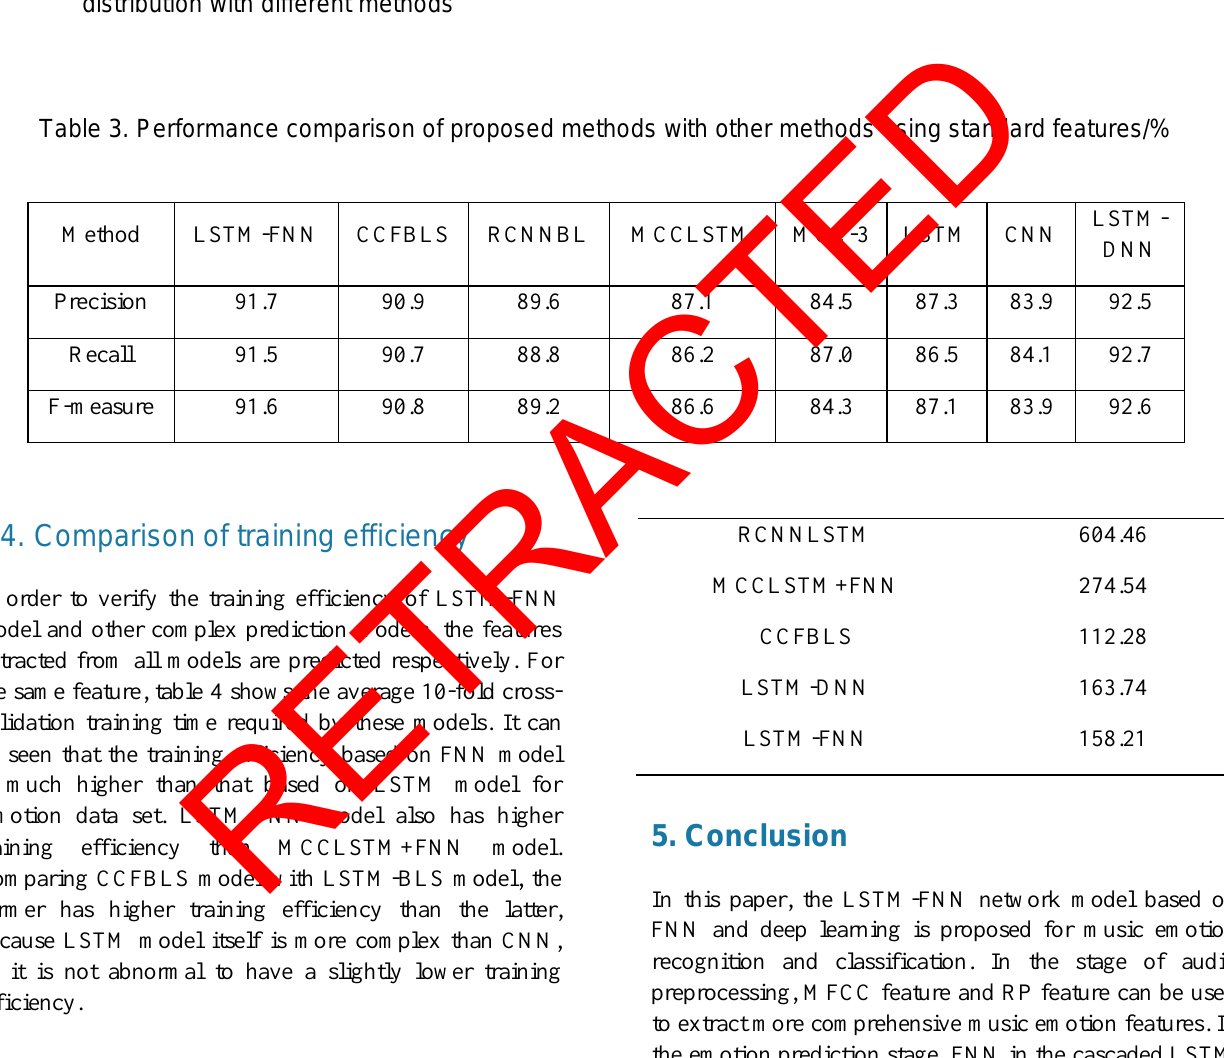
Table 4. Training efficiency comparison with different